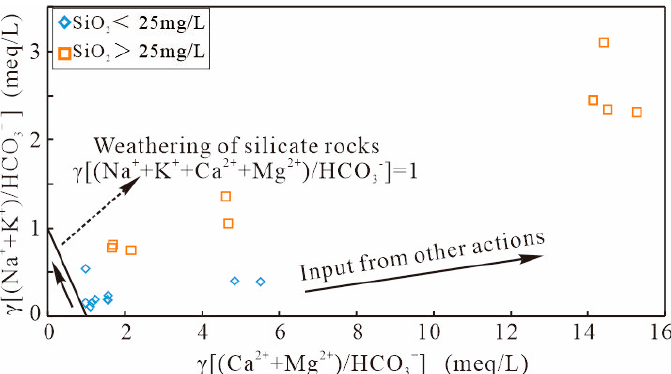
Figure 8. Relative contributions from silicate and carbonate weathering by H 2 CO 3 .